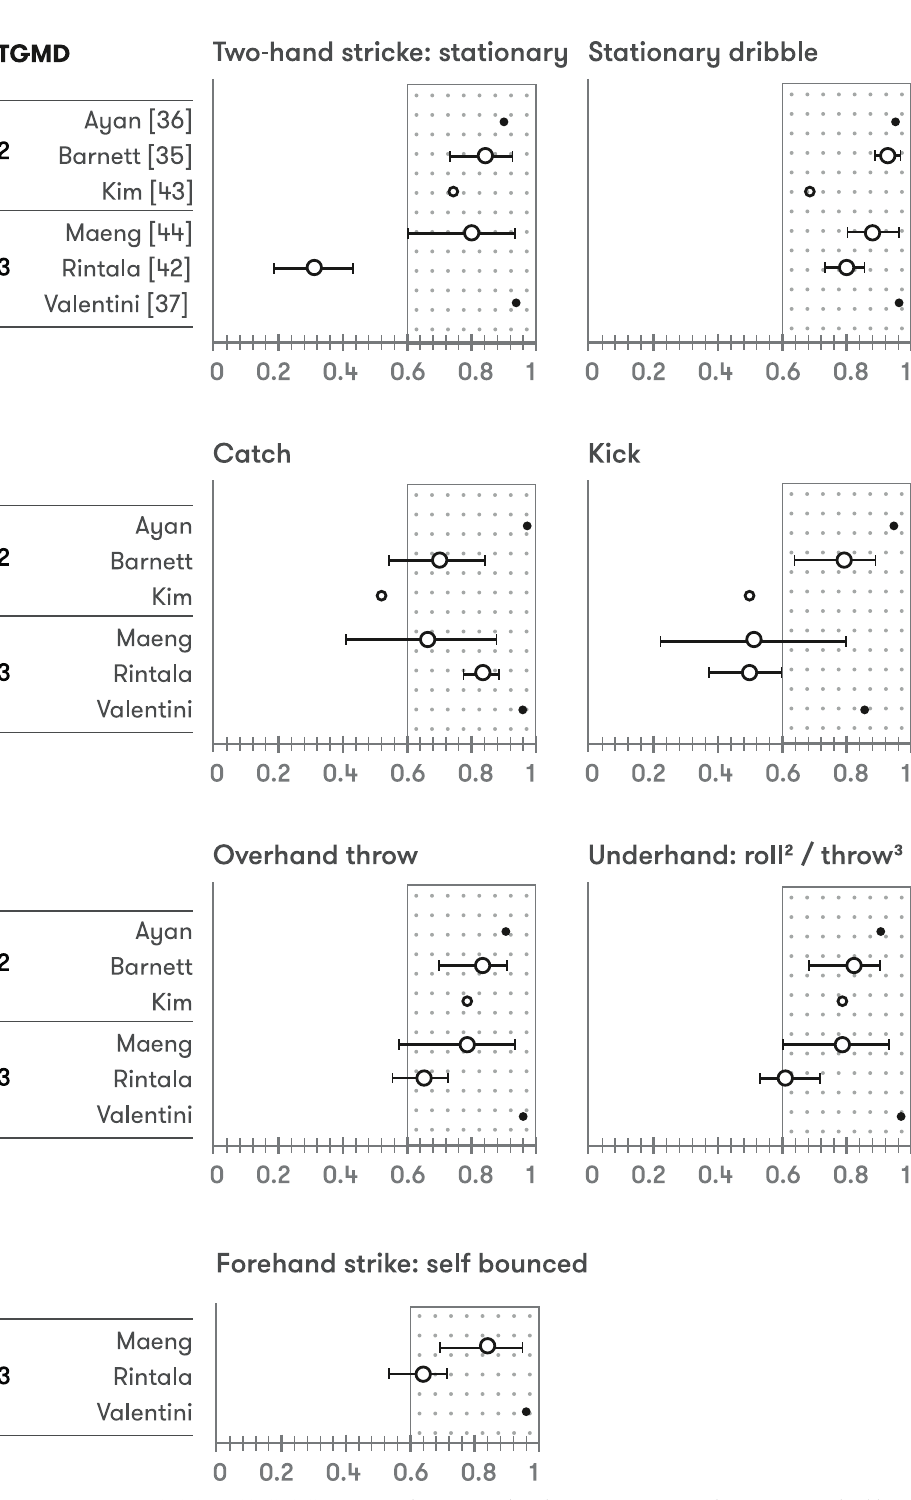
Fig 3. Inter-rater reliability of ball skills. Open circles : very good quality assessment according COSMIN checklist; Closed circles : adequate quality assessment according COSMIN checklist; Larger circles : ICC & 95%CI; Smaller circles : ICC.